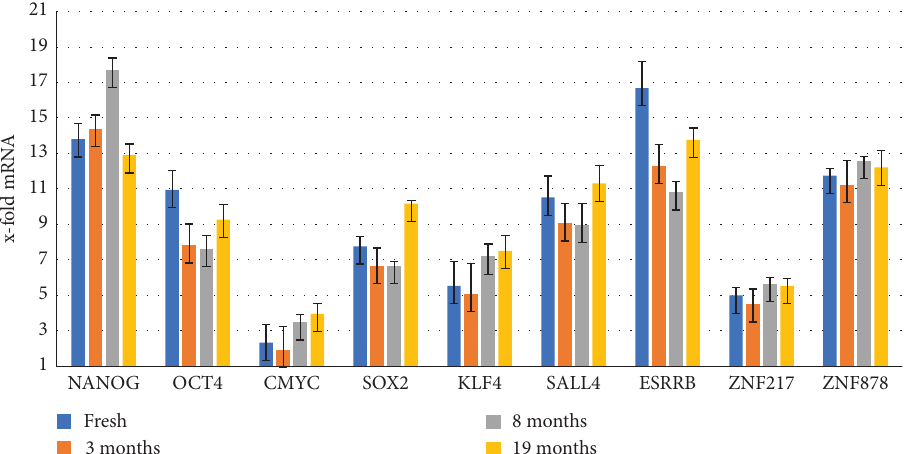
Figure 4: Analysis of the molecular profle of SCAPs before and after freezing reveals that no changes occur even after 19 months in liquid nitrogen.